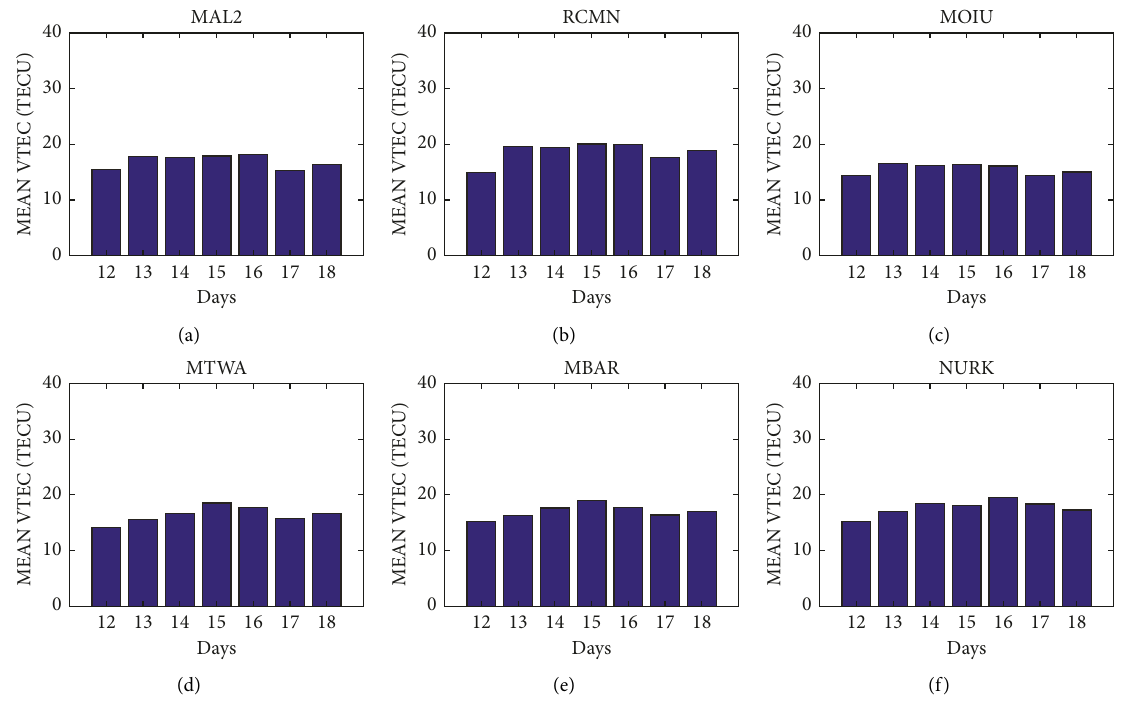
Figure 2: Daily mean VTEC over (a) MAL2, (b) RCMN, (c) MOIU, (d) MTWA, (e) MBAR, and (f) NURK stations for days 12 th to 18 th January 2010.